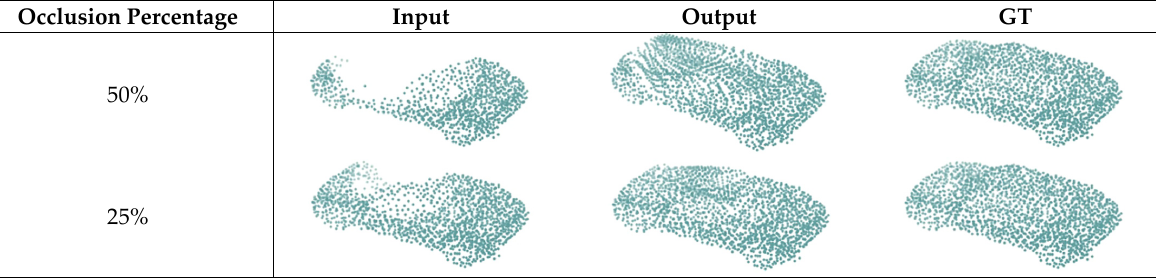
Figure 8. The completion shape of different occlusion percentages.